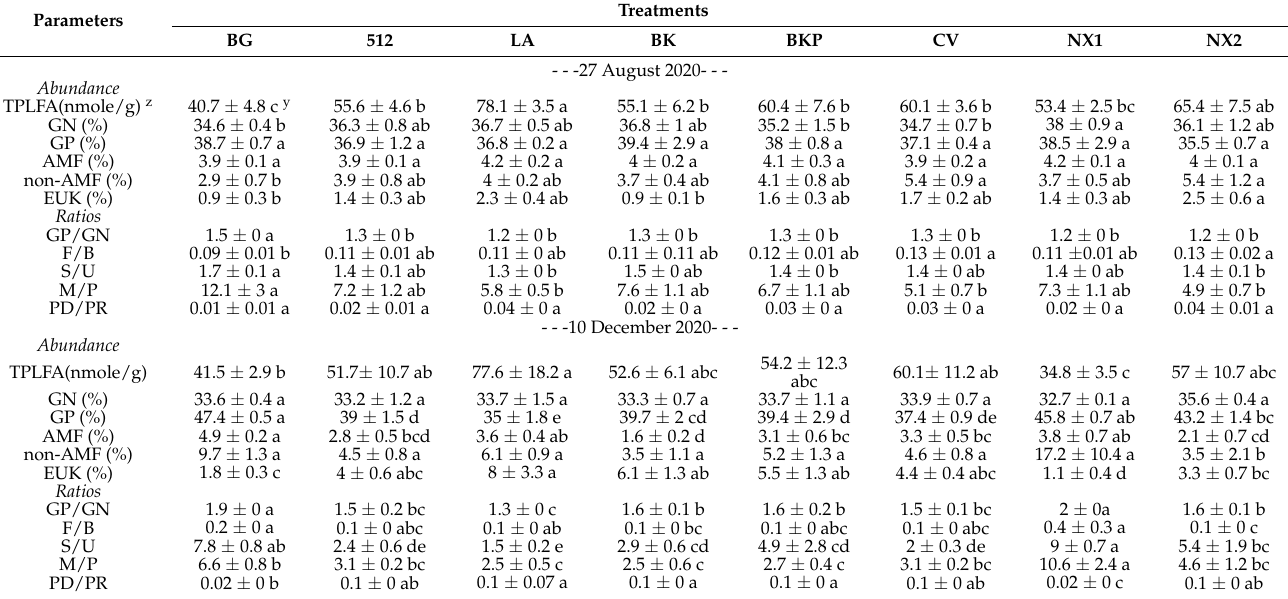
Table 4. Effect of SSgH on soil microbial profile based on